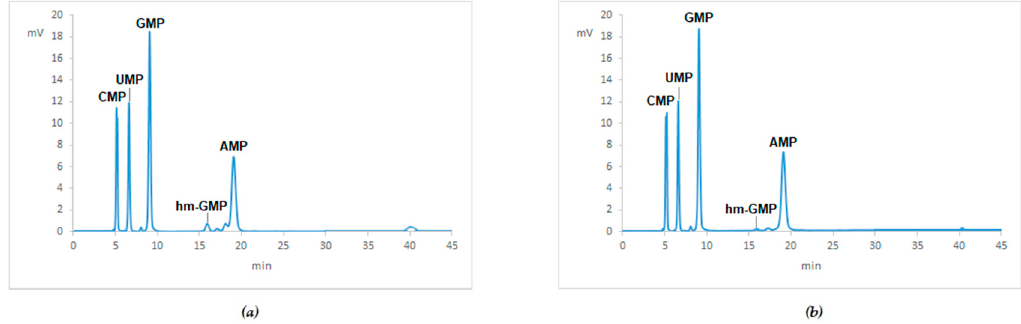
Figure A4. Chromatogram of: ( a ) prostate cancer FFPE tissue without RNA de-modification step and ( b ) with de-modification step.